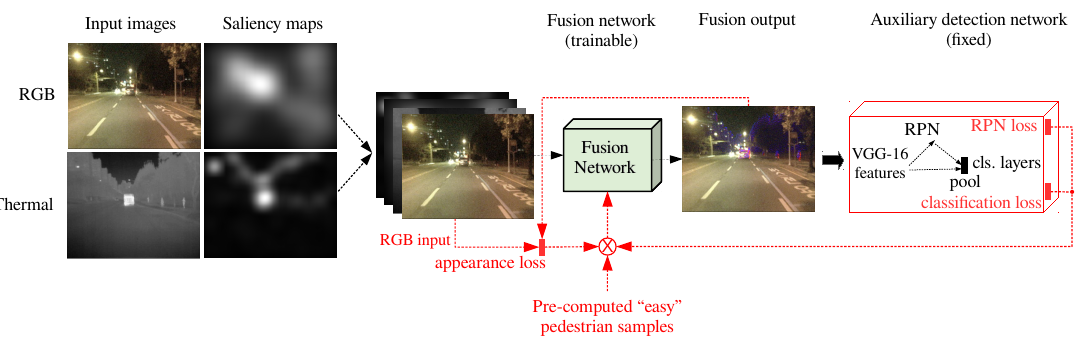
Figure 3. Diagram of the detection-guided learning of the fusion function. The red color represents the operations performed during training related to estimation of the losses. Both appearance and auxiliary detection losses are combined to train the fusion network. Please note that the auxiliary classification network is only used during